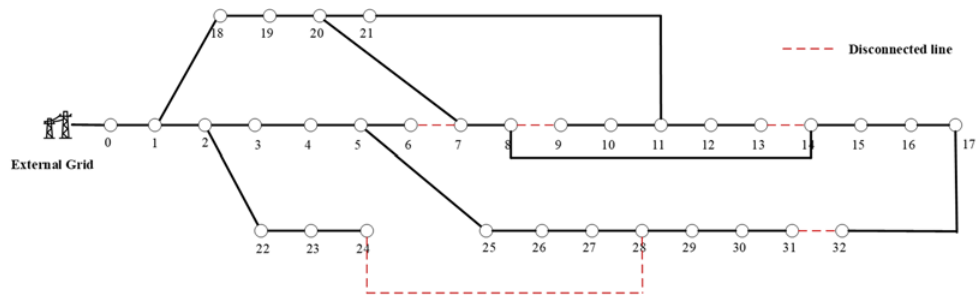
Figure 5. Radial structure of IEEE distribution network.